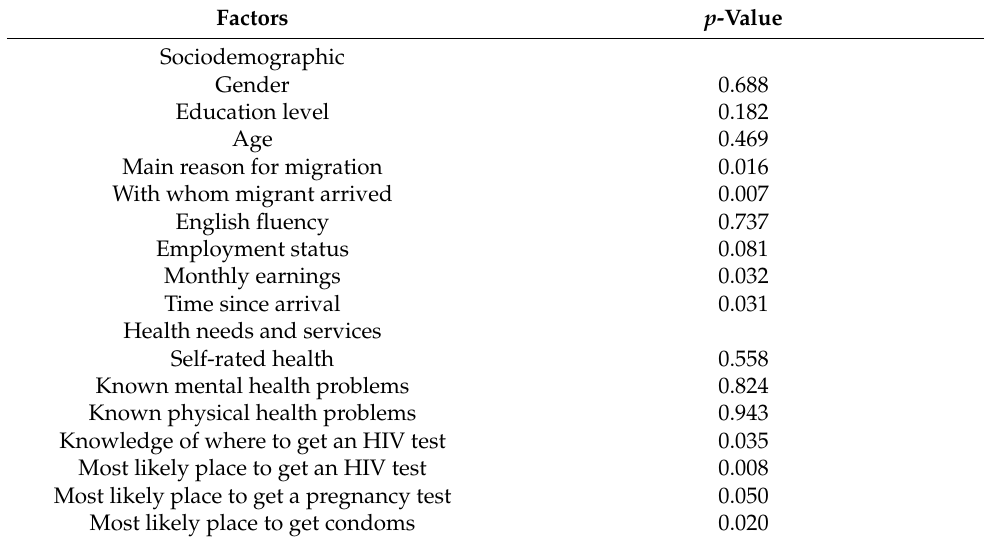
Table 5. Factors associated with having trouble accessing public health services while in Trinidad.